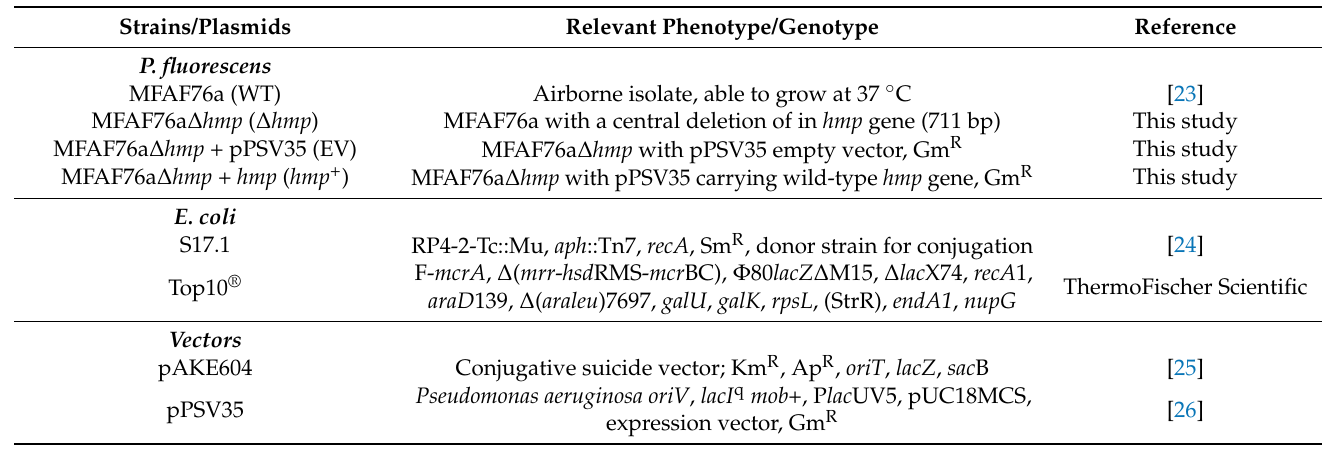
Table 1. Strains and plasmid used in this study. Gm R : gentamycin resistance; Km R : kanamycin resistance, Ap R : Ampicillin